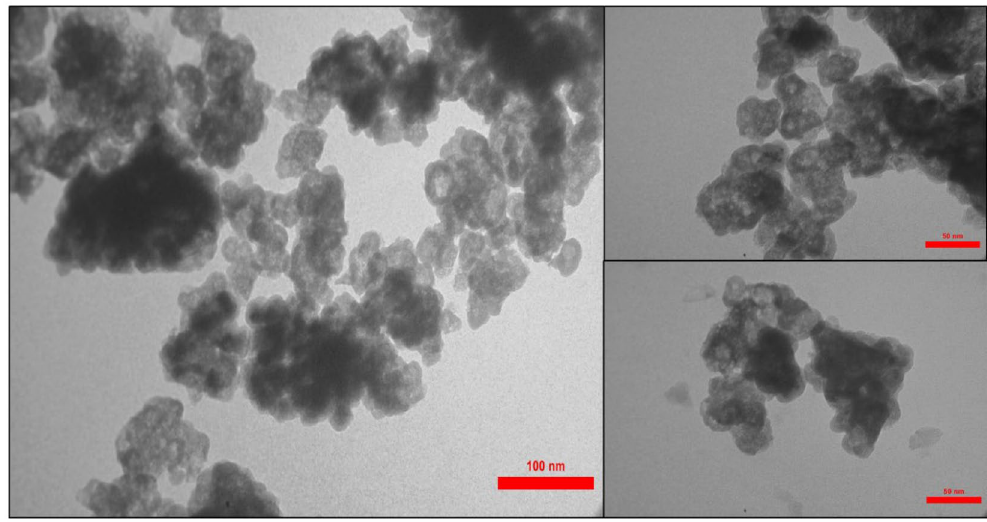
Figure 2. TEM images of n-Fe 3 O 4 @SiO 2 -TA-SO 3 H